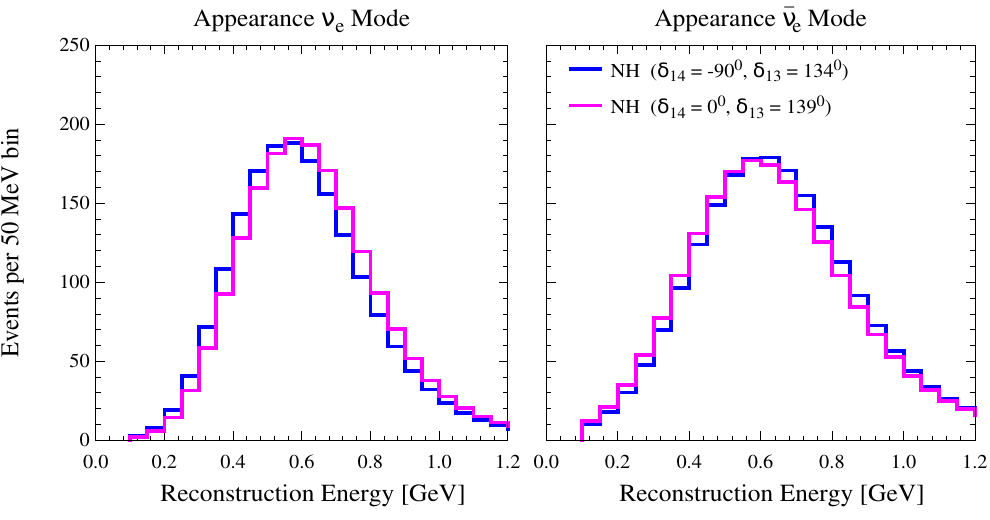
Figure 6 . Energy spectra for neutrinos (left panel) and antineutrinos (right panel) obtained for NH. The magenta histograms correspond to a case of no CPV induced by (cid:14) 14 ( (cid:14) 14 = 0). The blue histograms correspond to a case of maximal CPV induced by (cid:14) 14 ( (cid:14) 14 = (cid:0) 90 0 ). The two values of (cid:14) 13 have been chosen in order to have complete degeneracy at the level of both neutrino and antineutrino events. These choices of phases correspond to one of the sixteen crossing points in the right panel of (cid:12)gure 3 (therein indicated by a cyan star). The di(cid:11)erence in the spectra is in this case the only source of sensitivity to the CPV induced by (cid:14) 14 , which is (cid:24) 3 : 5 (cid:27) according to the left panel of (cid:12)gure 5 for (cid:14) 14 = (cid:0) 90 0 .